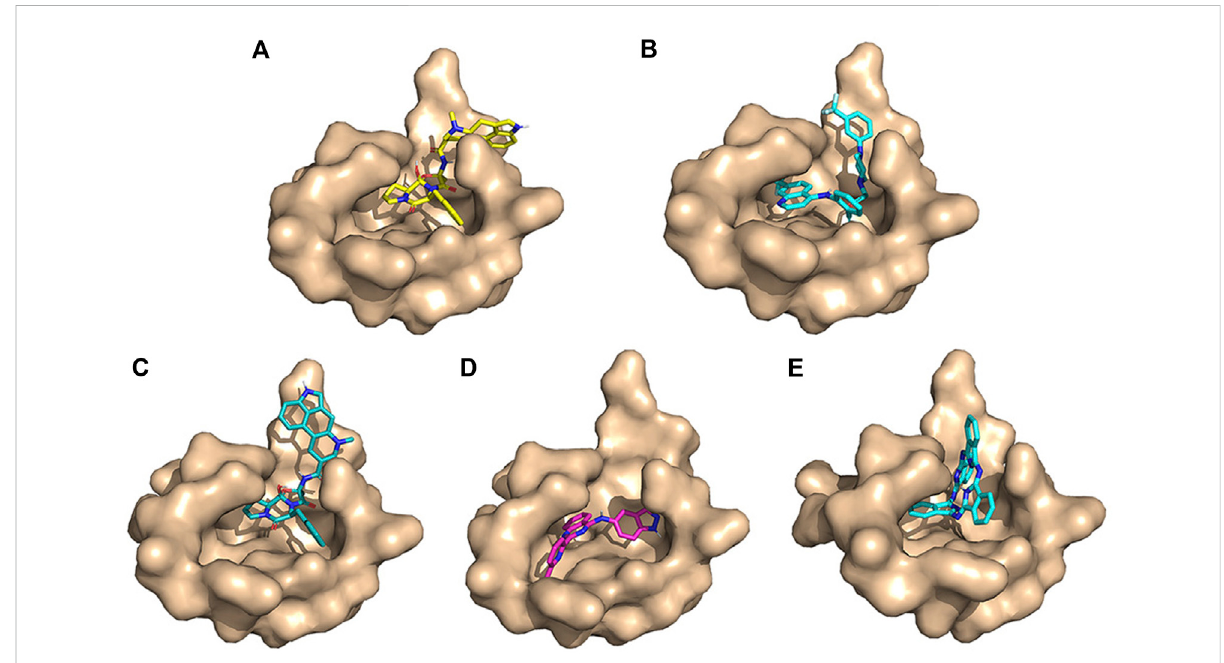
FIGURE 5 Conformation diagrams of these compounds. (A) Ergotamine; (B) antrafenine; (C) dihydroergotamine; (D) N-1H-indazol-5-yl-2-(6-